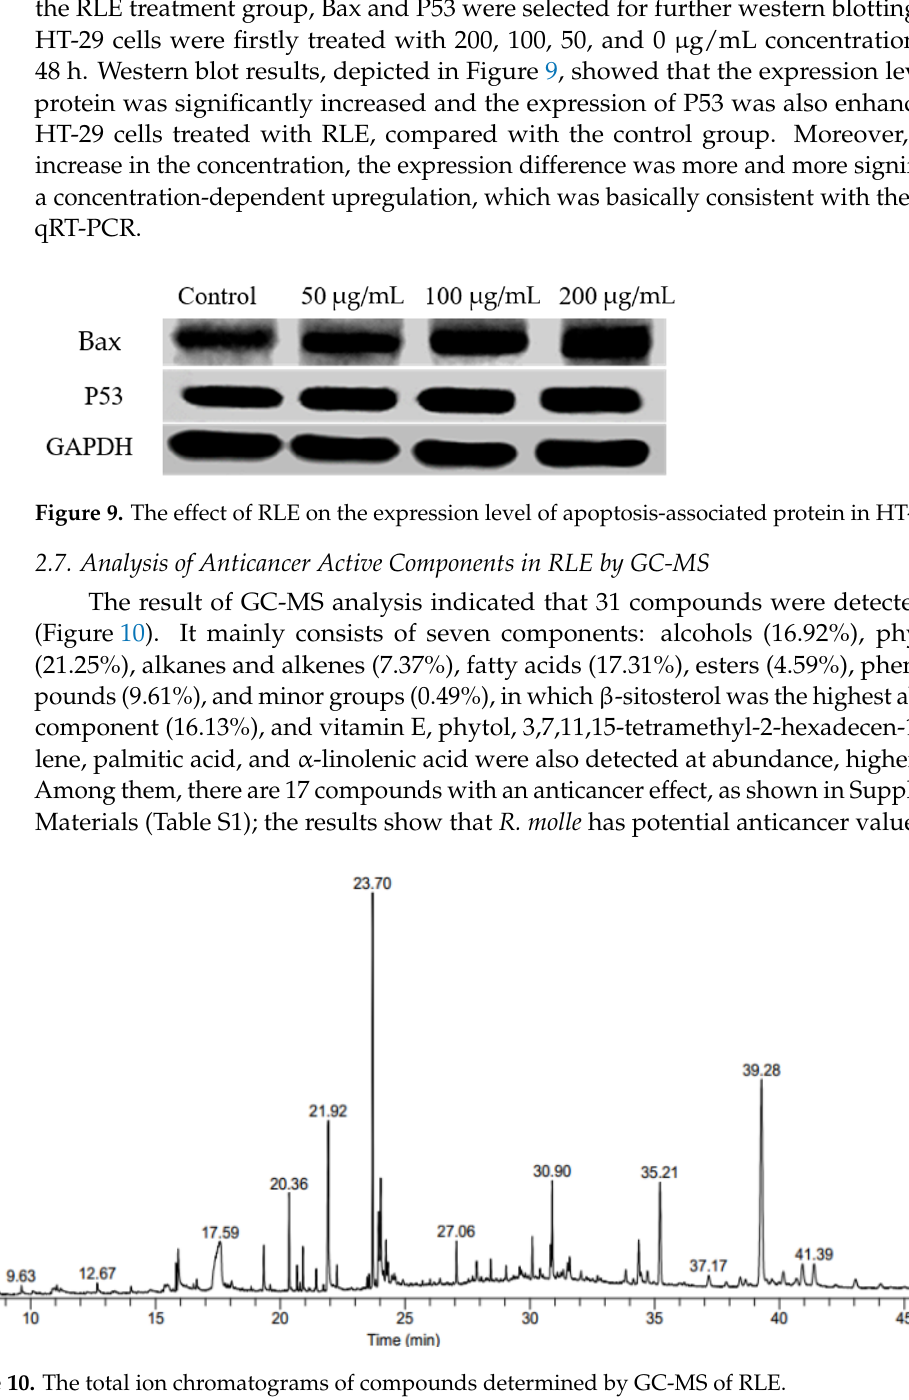
Figure 8. Effect of RLE on expression of cell cycle and apoptosis-associated genes on HT-29 cells